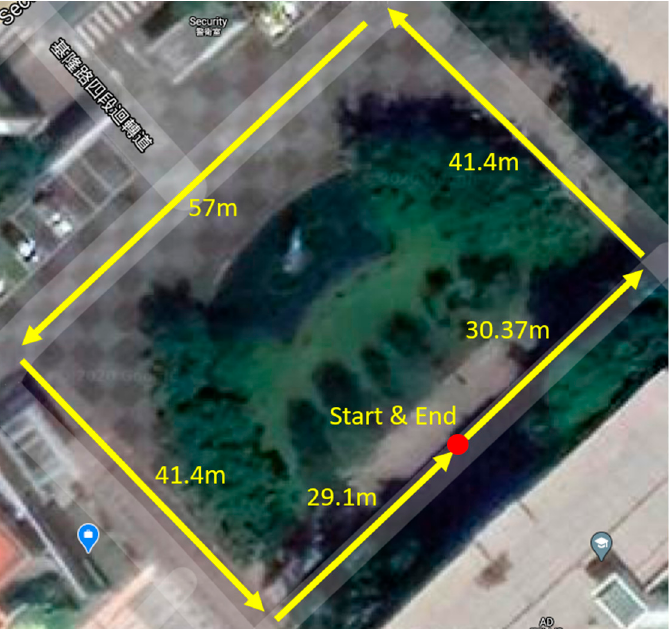
Figure 8. A rectangular path on the NTUST campus for vehicle positioning validation.